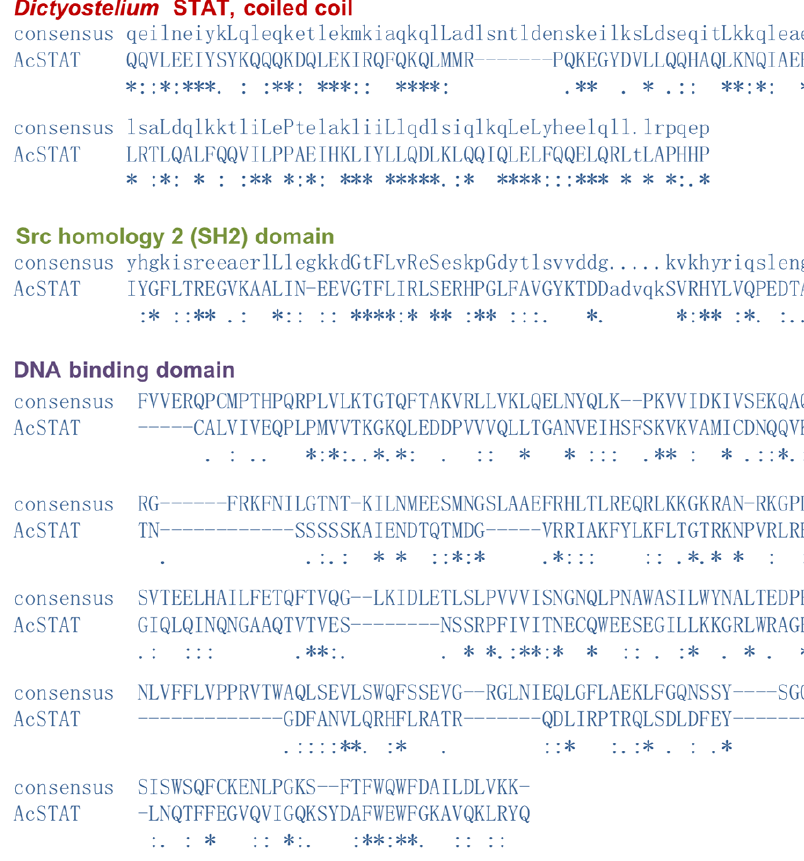
Figure 2. Alignment of STAT consensus sequences of the structural elements with the A.castellanii STAT functional domains. ‘‘*’’, positions with a single, fully conserved residue; ‘‘:’’, conservation between groups of strongly similar properties; ‘‘.’’, conservation between groups of weakly similar properties. doi:10.1371/journal.pone.0111345.g002 Table 1. Protein sequences similar to A. castellanii STAT (accession number